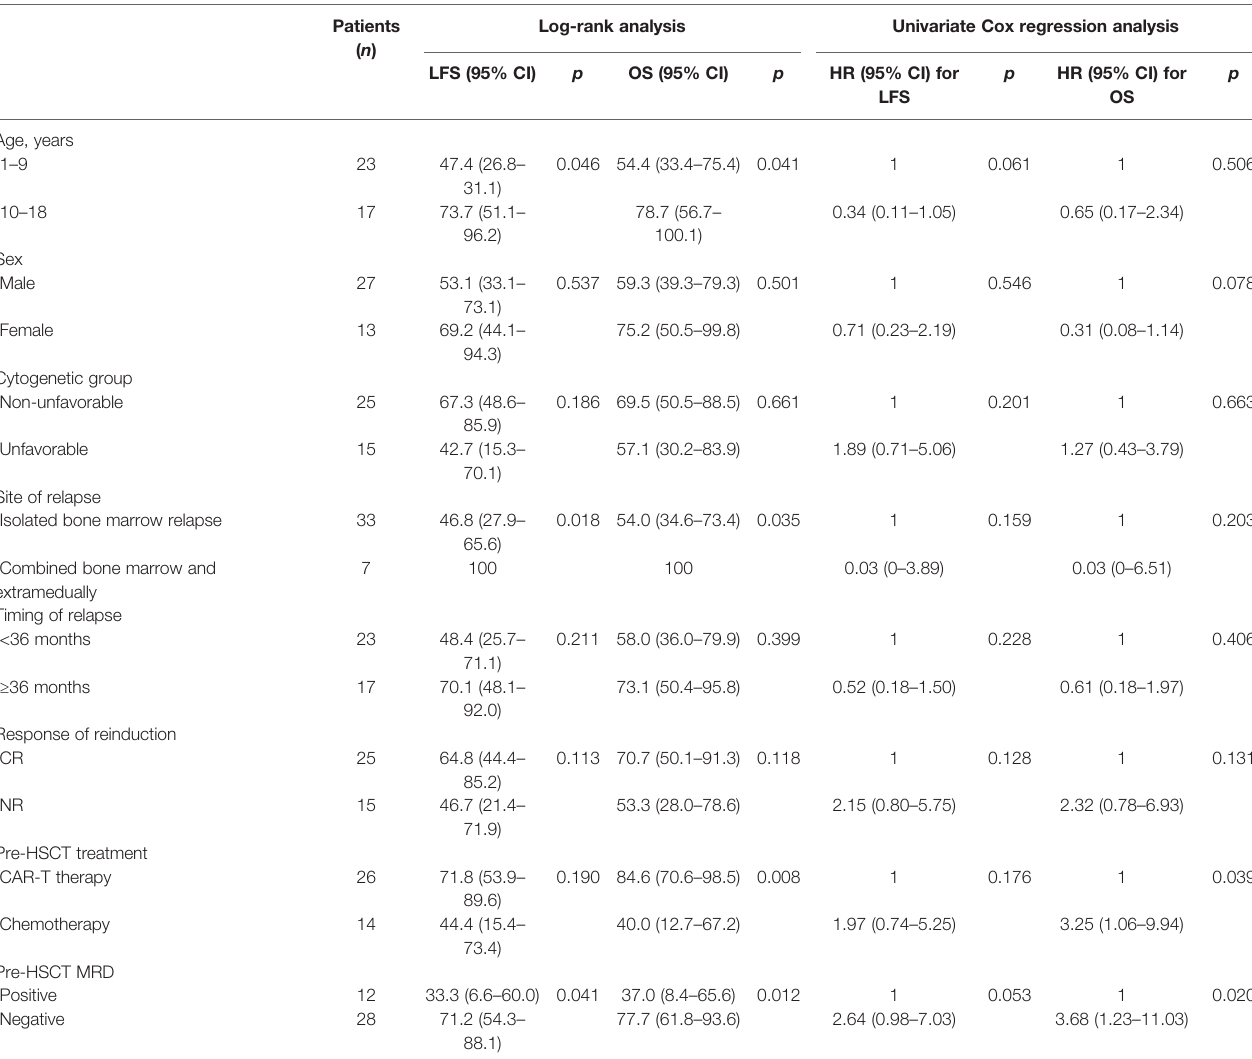
FIGURE 2 | LFS rate and OS rate for patients in the CAR-T group and patients in the chemotherapy group. CAR-T, chimeric antigen receptor T cells; LFS, leukemia-free surival; OS, overall survival. TABLE 2 | Clinical characters and their association with